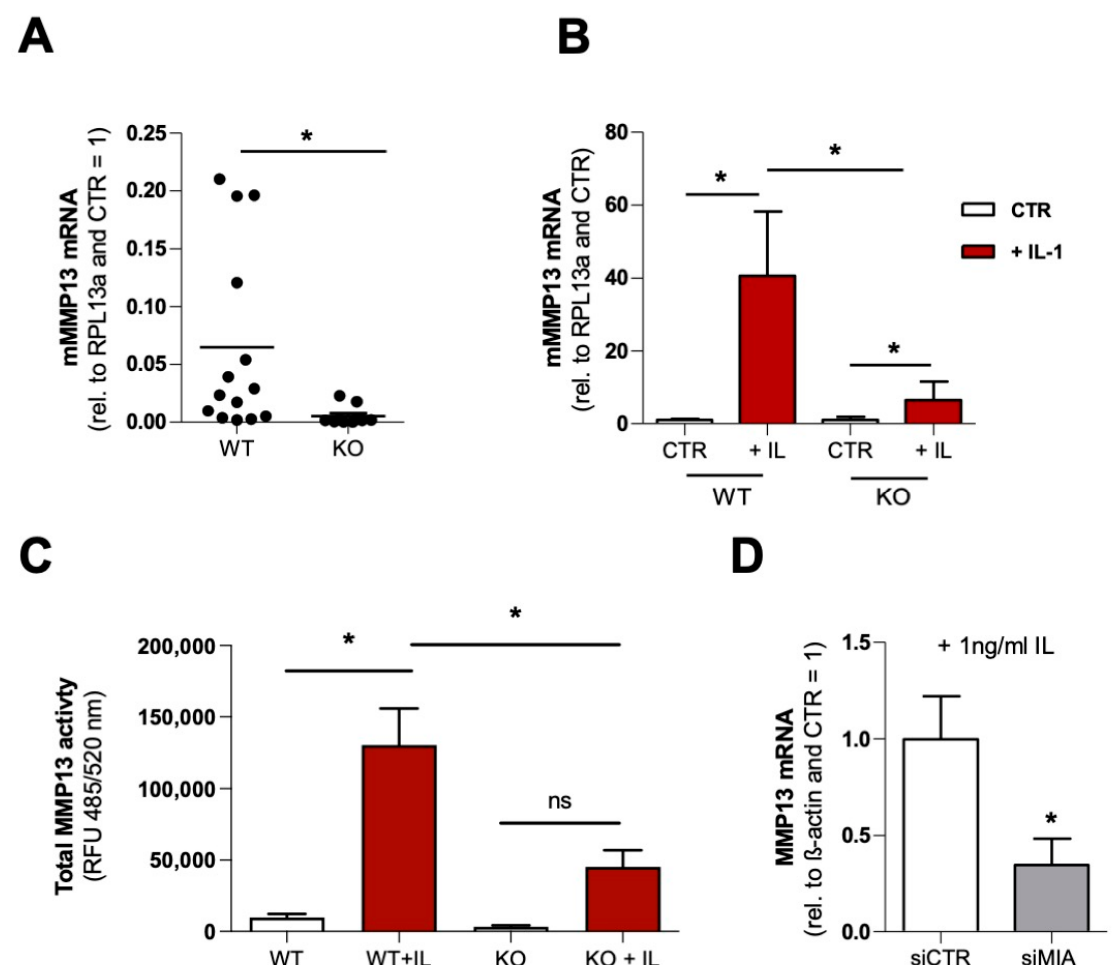
Figure 2. ( A ) Quantitative RT-PCR analysis of MMP13 in murine chondrocytes derived